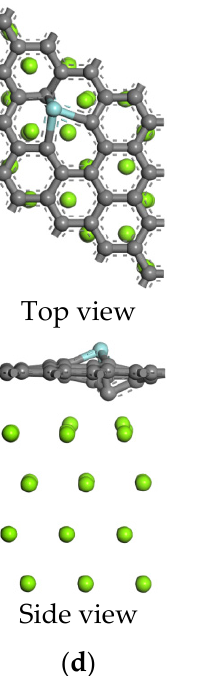
Figure 7. The top and side views of the five interface models after geometry optimization: ( a ) Al- doped interface, ( b ) Mn-doped interface, ( c ) Zn-doped interface, ( d ) Zr-doped interface, ( e ) intrinsic interface.